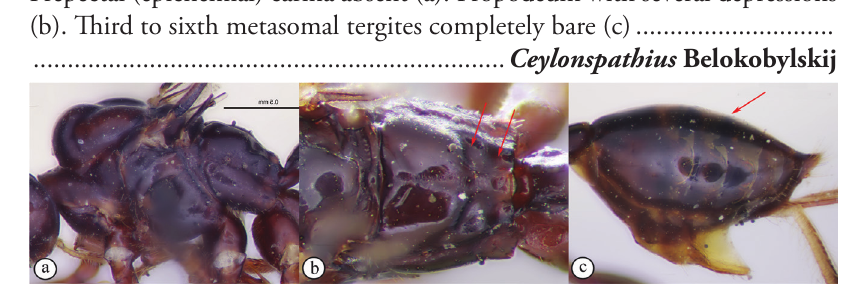
Brachial (subdiscal) cell of fore wing widely open postero-distally (A). Second metasomal tergite with distinct, complete and posteriorly convergent lon- gitudinal furrows (B). In male, second radiomedial vein (r-m) of fore wing